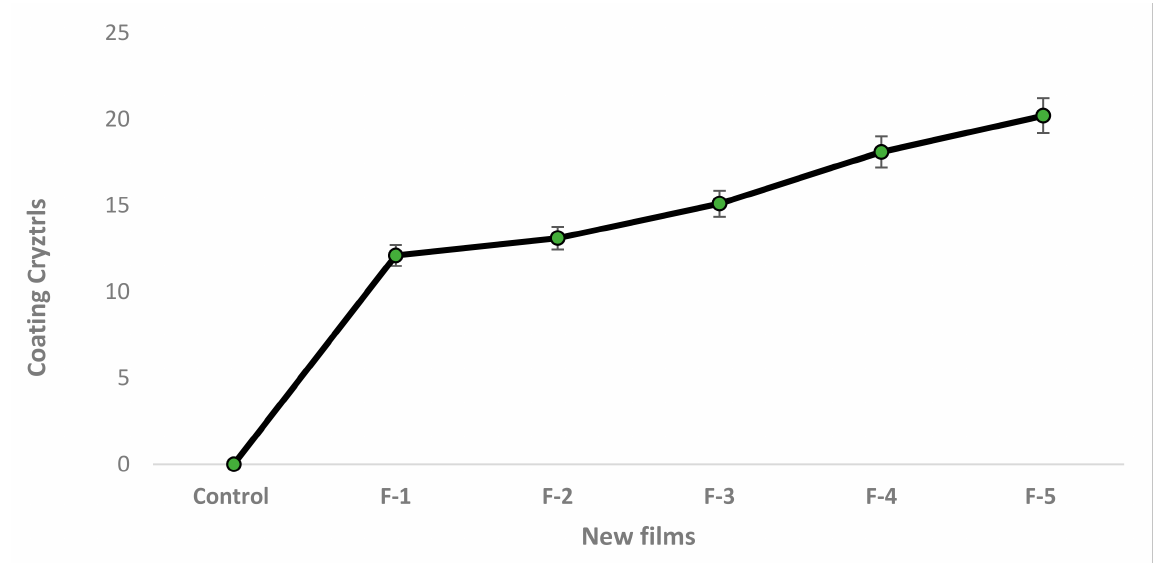
Figure 2. Changes in coating crystal and thickness in